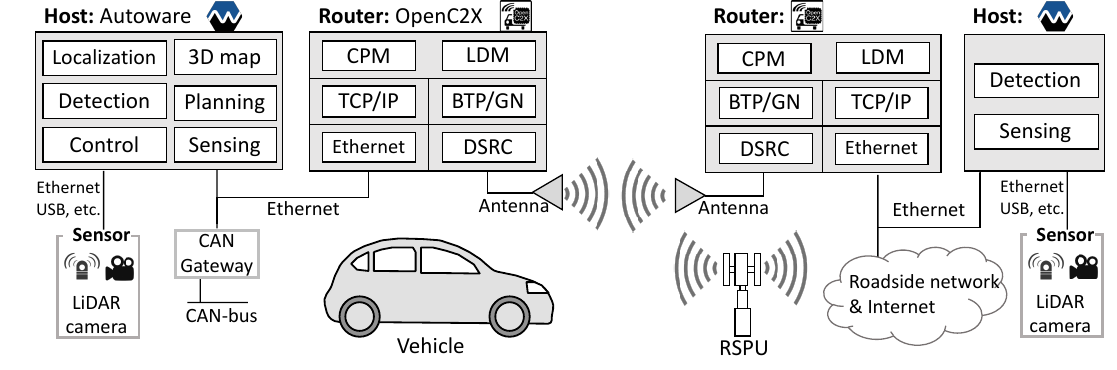
Figure 2. System model to integrate Autoware and